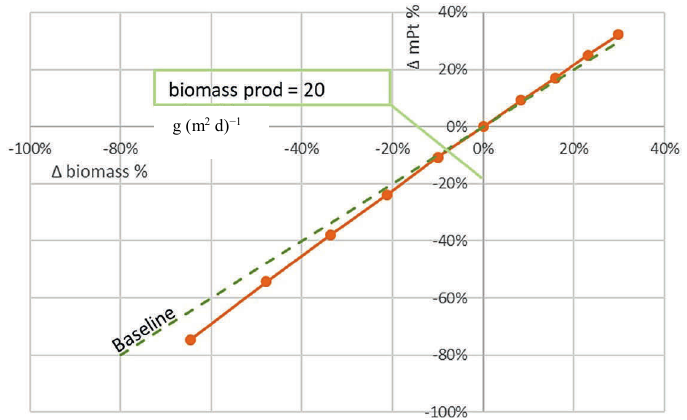
Fig. 12. Biomass productivity impact on environmental score.